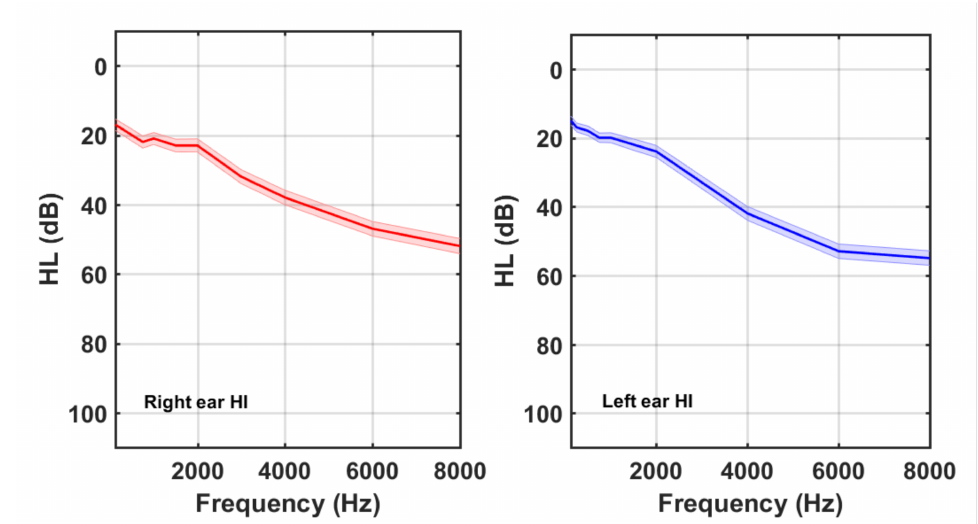
Figure 3. Right and left ear averaged HL curves for tinnitus participants of the HI subgroup.